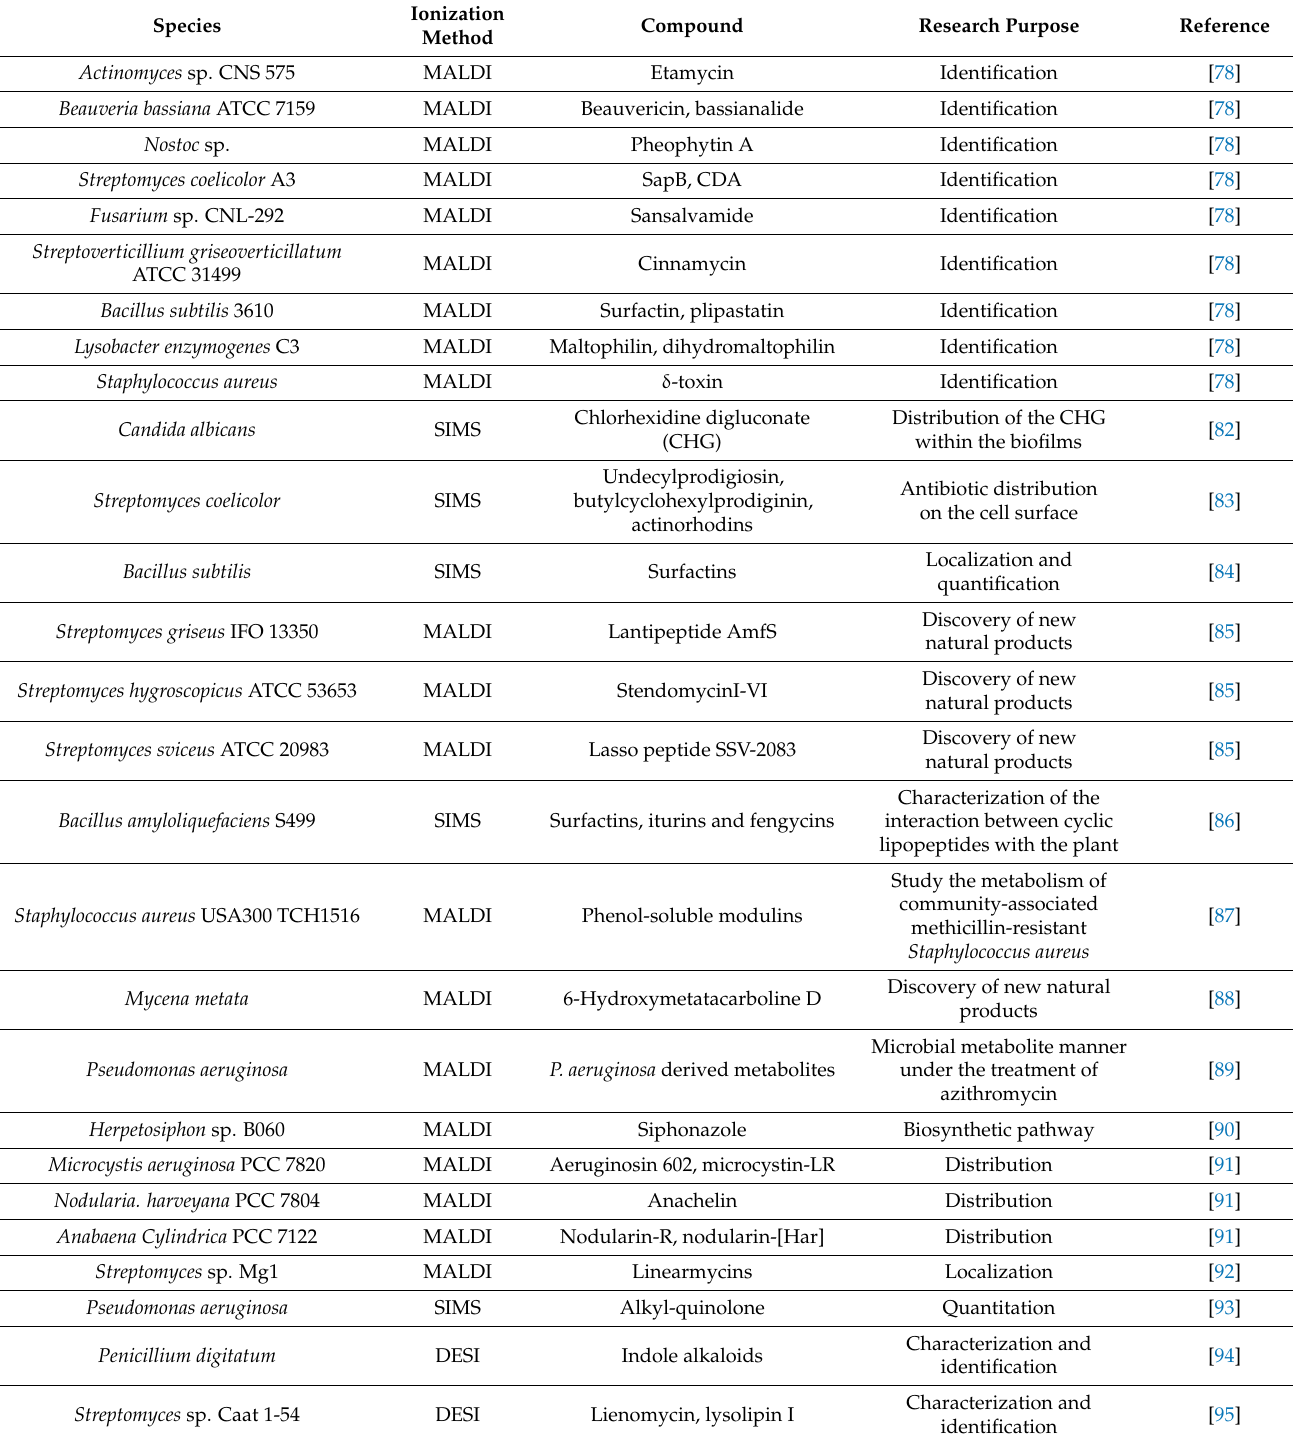
Table 4. MSI application in the research of monocultured microbial NPs or